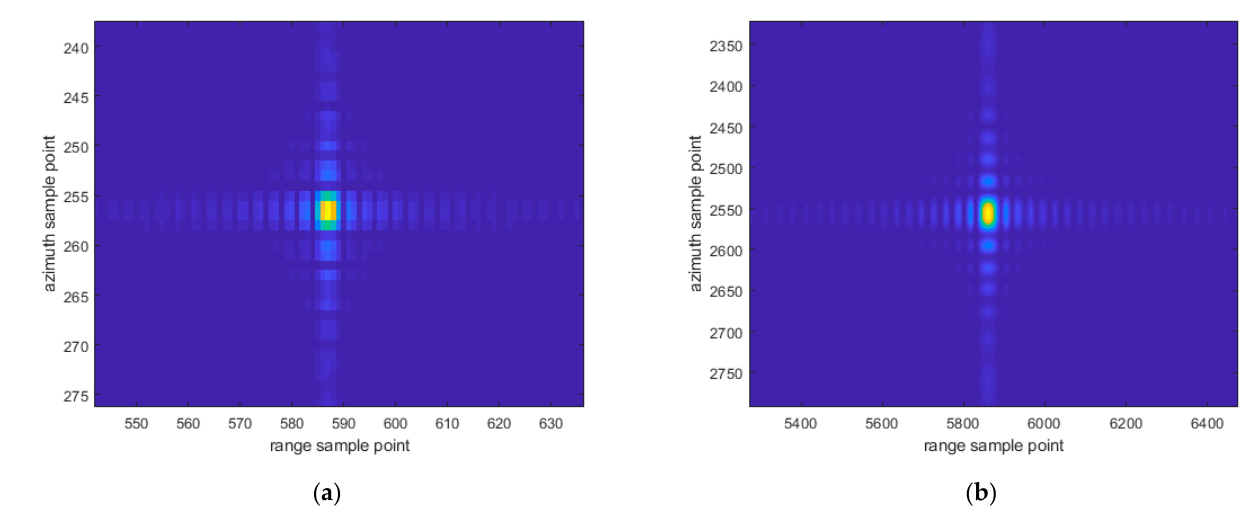
Figure 5. Point target simulation. ( a ) Before interpolation; ( b ) after interpolation. Table 3. Time delay error estimation results of multi-channel